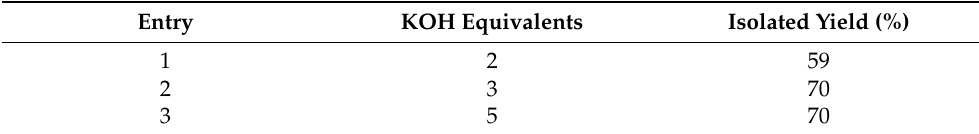
Table 1. Effect of KOH equivalent in the synthesis of diaryl ether 2 . Entry KOH